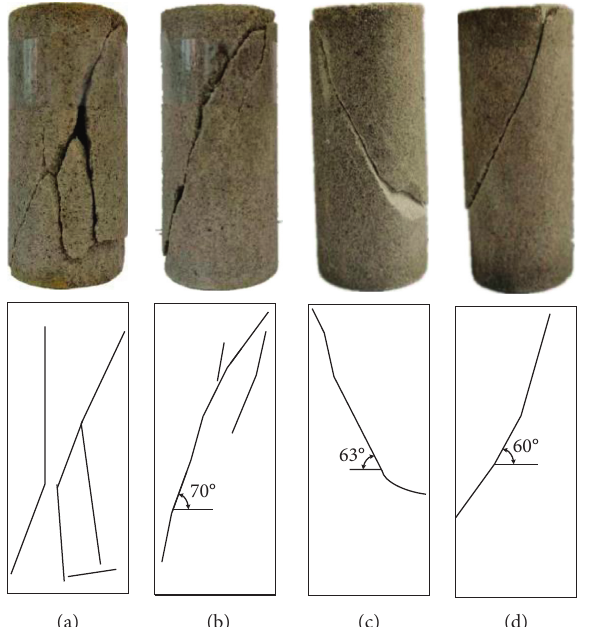
Figure 4: Failure characteristics of typical specimens with different confining pressures: (a) 0MPa, (b) 5 MPa, (c) 10MPa, and (d) 15MPa.